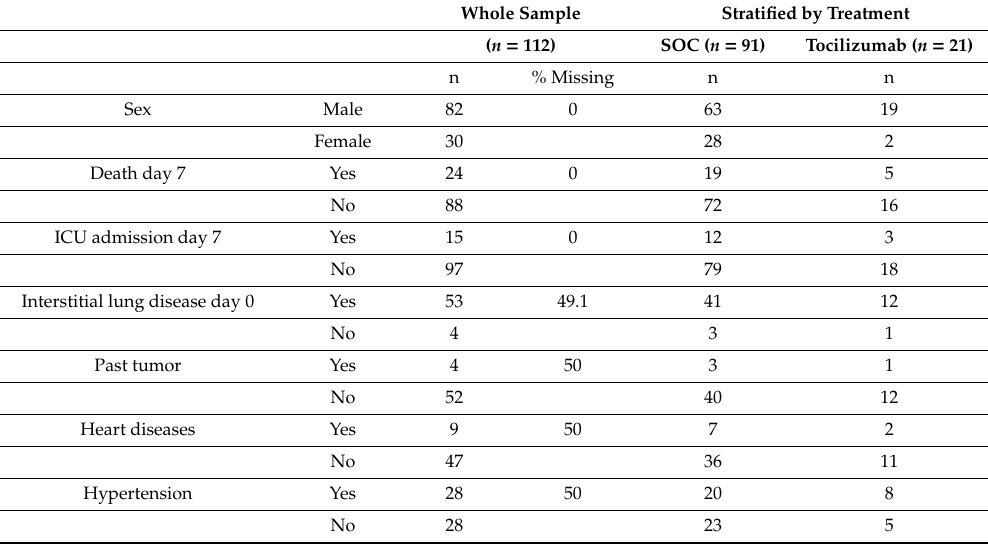
Table 1. Frequencies of demographic and clinical characteristics of the SMACORE cohort. Whole